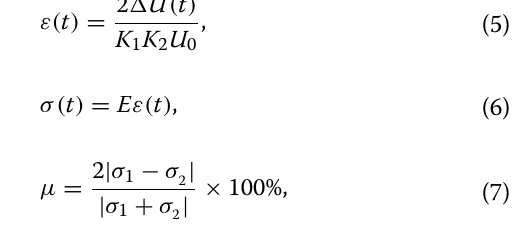
high strain rate, the main crack does not propagate, and the impact energy is absorbed by the microc- racks and weak interfaces in the specimens, result- ing in multi-point microcracks and serious damage. The specimens with other mixing amounts (5–30%) show similar failure law, which is not repeated here. (3) Energy calculation The voltage time-history curve derived from the testing machine is shown in Fig. 14a. Through Eqs. (5–6), the three-wave stress diagram is cal- culated as shown in Fig. 14b. According to the similar stress difference Eq. (7), the stress uni- formity is calculated to ensure the accuracy of the experimental data. The final calculation result × 100% = 4.82% < 5% , meets µ = 2 | 84.91 − 89.11 | | 84.91 + 89.11 | the stress uniformity assumption, and the experi- mental data are accurate.